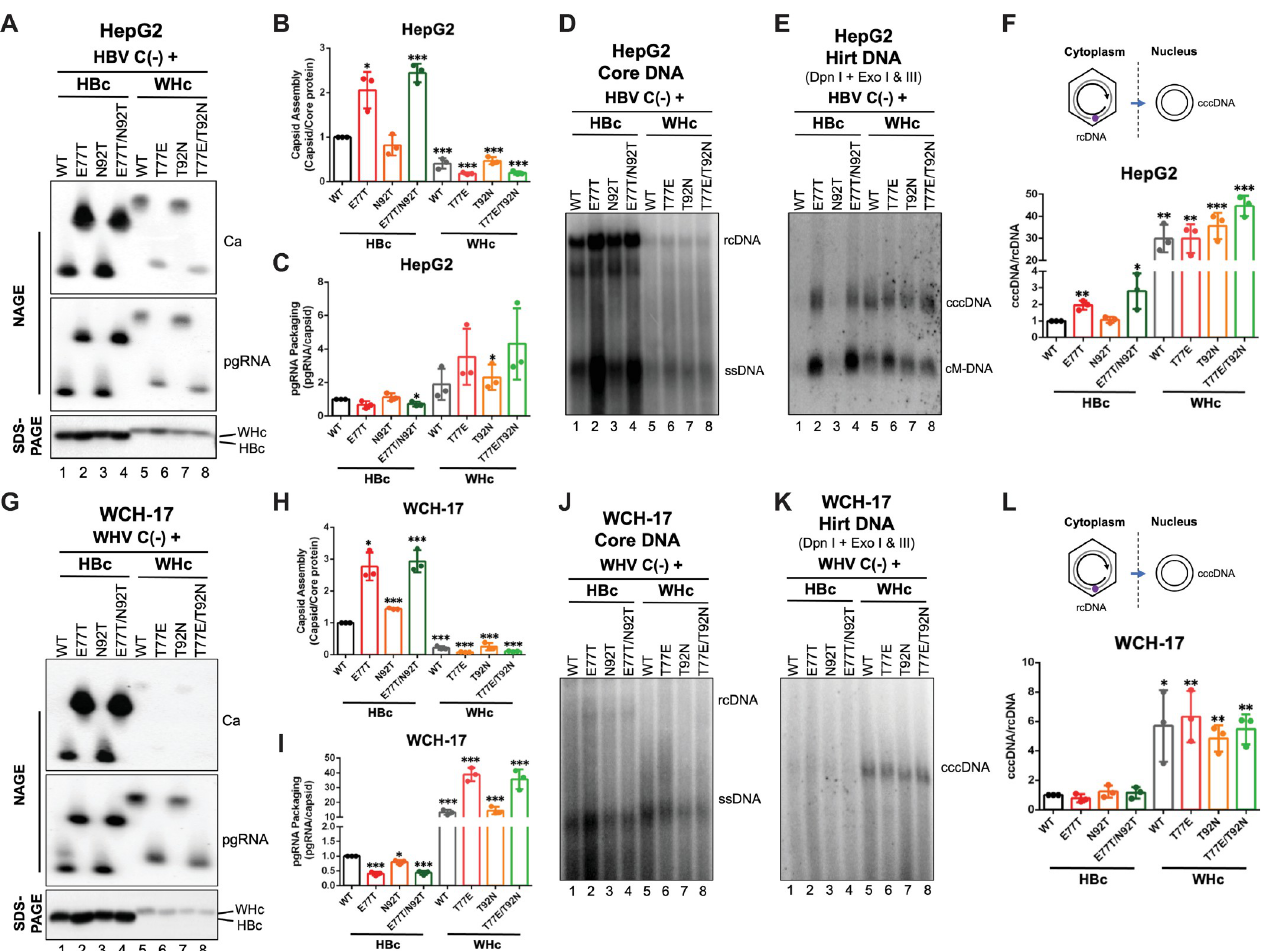
Fig 6. Effects of WT and mutant HBc or WHc on supporting the replication of HBV and WHV. The HBV replicon construct that is defective in HBc expression was co-transfected with WT and mutant HBc or WHc expression constructs in HepG2 cells. (A) The assembled capsids (top) and packaged pgRNA (middle) were detected by the C33 anti-HBc/WHc mAb and anti-sense HBV RNA probe, respectively, following the resolution of cytoplasmic lysates by NAGE and transfer to nitrocellulose membrane. Levels of HBc or WHc proteins (bottom) were measured by western blot using 19C18 anti-HBc/WHc mAb after SDS-PAGE. Quantitative results of capsid assembly efficiency (B) and pgRNA packaging efficiency (C) were obtained as described in Fig 4 and are shown. (D) core DNA was released from the NCs of cytoplasmic lysate by SDS-proteinase K treatment and detected by Southern blot analysis. (E) PF-DNA was extracted by the Hirt extraction method. The extracted DNA was treated with DpnI plus Exo I & III to remove all DNA with free 3’ ends. The cccDNA formation efficiency (F) was determined by normalizing the levels of cccDNA to those of rcDNA, with the efficiency from WT HBc set to 1.0. Similarly, a WHV replicon construct that is defective in WHc expression was co-transfected with WT and mutant HBc or WHc expression constructs in WCH-17 cells. (G) The assembled capsids (top) and packaged pgRNA (middle) were detected by the C33 anti-HBc/WHc mAb and anti-sense WHV RNA probe, respectively. Levels of HBc or WHc proteins (bottom) were measured by western blot using 19C18 anti-HBc/WHc mAb after SDS-PAGE. Capsid assembly efficiency (H) and pgRNA packaging efficiency (I) were determined as described above and are shown. (J) core DNA and (K) PF-DNA from the transfected cells was analyzed by Southern blot analysis. (L) cccDNA formation efficiency of WHV was determined by normalizing the levels of cccDNA to those of rcDNA, with the efficiency from WT HBc set to 1.0. Data is shown as mean ± SD. Two-tailed unpaired Student’s t test was used to compare the difference of each dataset versus WT HBc ( � , p < 0.05; �� , p < 0.01; ��� , p < 0.001). Ca, capsid; pgRNA, pregenomic RNA; HBc, HBV core protein; WHc, WHV core protein; ssDNA, single-strand DNA; rcDNA, relaxed circular DNA; cccDNA, covalently closed circular DNA; cM-DNA, closed minus strand